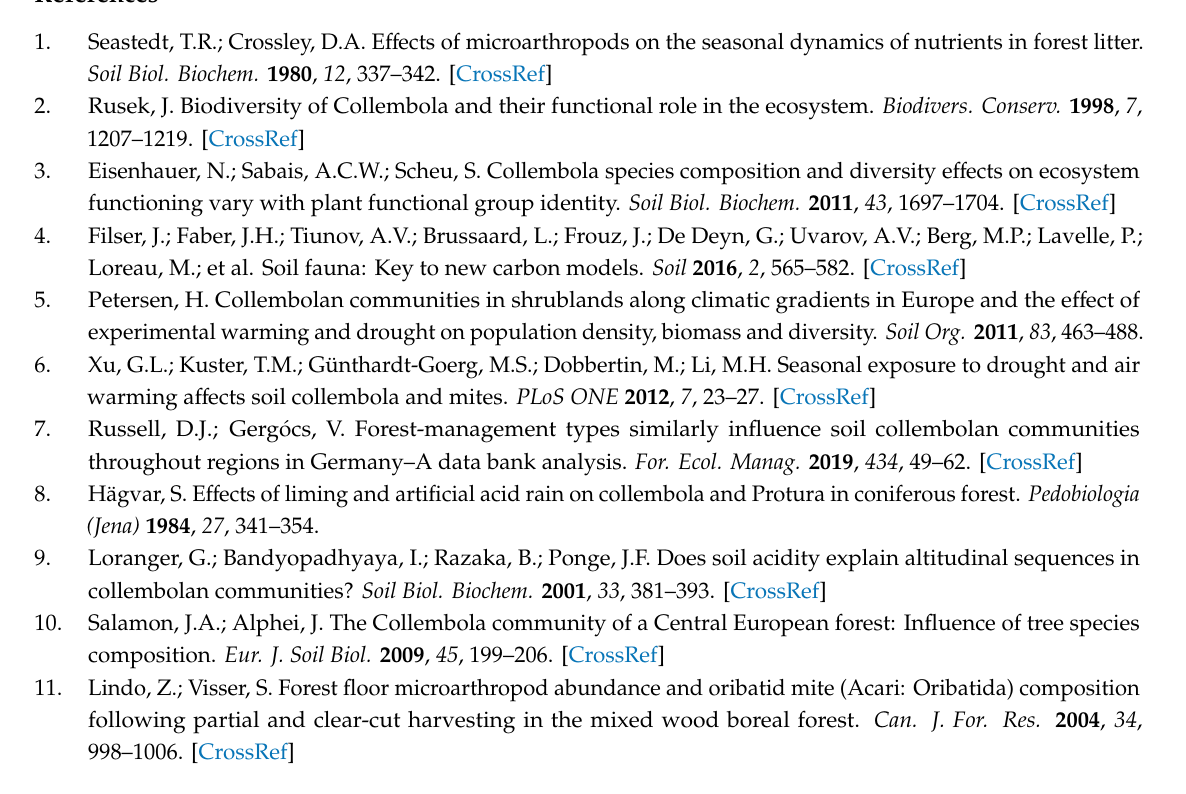
Figure S1: Plots bioturbated by wild boar (photo M. Sławski), Figure S2: Control plot (photo M. Sławski), Table S1: Results of power